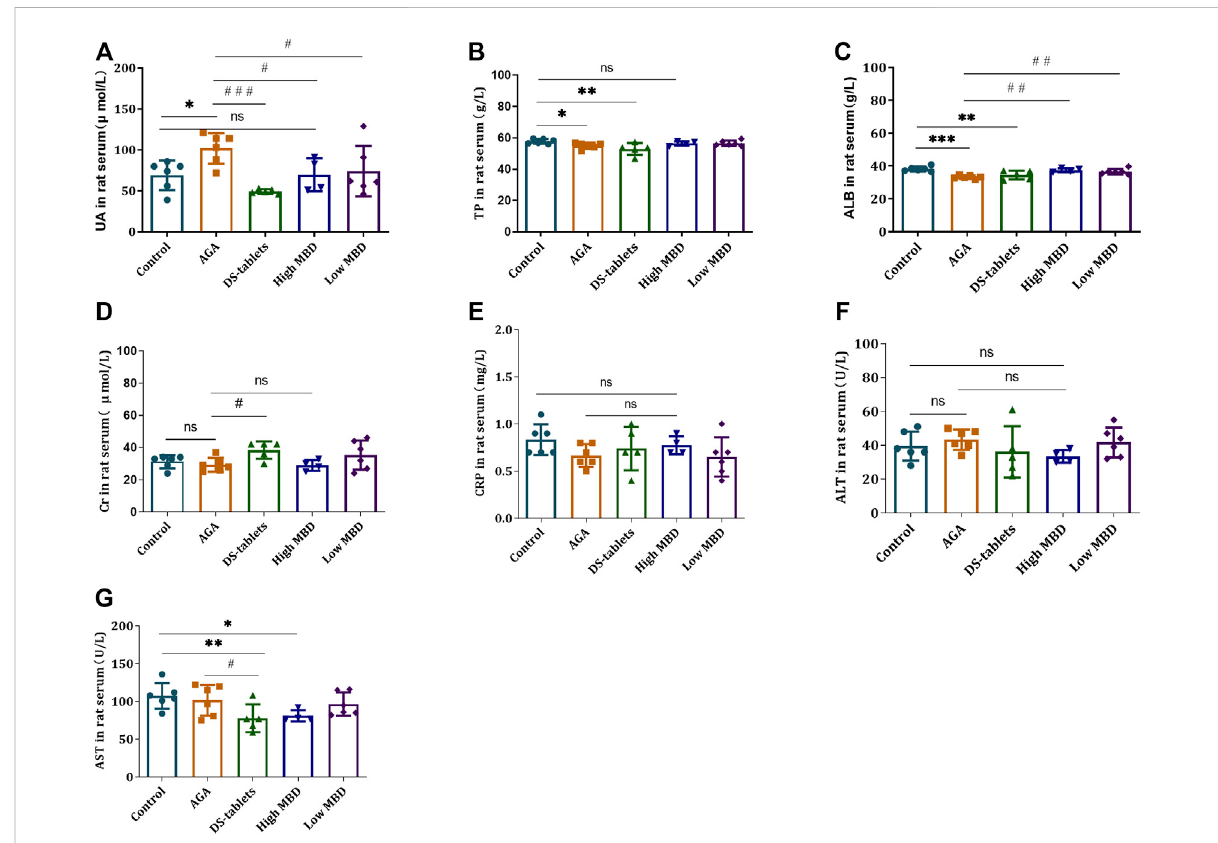
FIGURE 4 Effect of MBD on liver and kidney metabolic function and the expression of (A) uric acid (UA). (B) Total protein (TP). (C) Albumin (ALB). (D) Creatinine (Cr). (E) C-reactive protein (CRP). (F) Alanine aminotransferase (ALT). (G) Aspartate aminotransferase (AST) in serum ( n = 6/group). *p < 0.05, ** p < 0.01, *** p < 0.001 indicatedthatthedifferencewasstatisticallysigni fi cantcomparedwiththeControlgroup; # p < 0.05, ## p < 0.01, ### p < 0.001 compared with the AGA group, the difference was statistically signi fi cant. “ ns ” represents not signi fi cant.